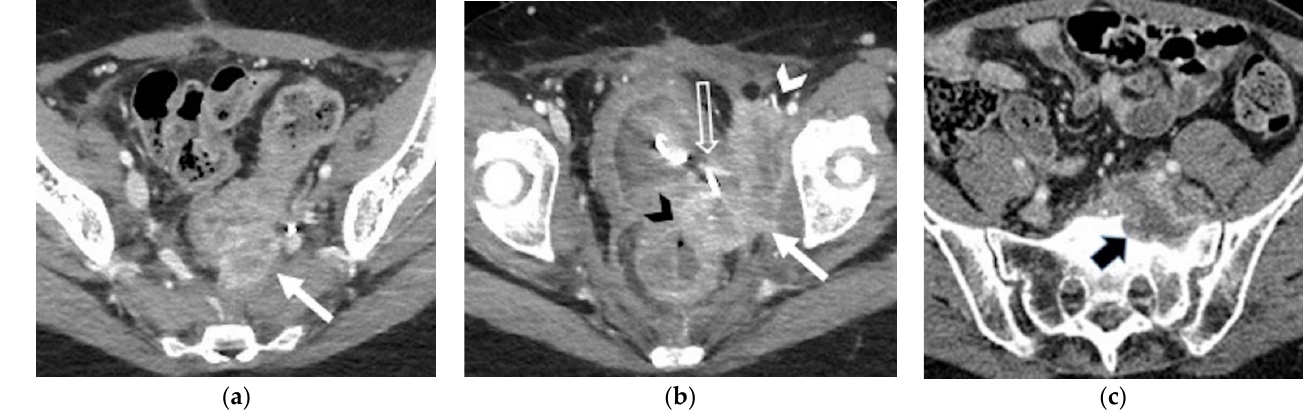
Figure 7. ( a , b ) A 36-year-old patient who underwent radical hysterectomy with bilateral salpingo– oophorectomy (BSO) and chemoradiation therapy for cervical cancer. Axial post-contrast CT images show pathological tissue infiltrating the left piriform muscle, the left internal obturator muscle (solid white arrow in ( a , b )) and the external iliac vein (white arrowhead in ( b )). Note the infiltration of the anterior rectal wall (black arrowhead in ( b )), the bladder and the left ureteral orifice (with the ureteral stent) (open arrow in ( b )). ( c ) A 58-year-old who underwent radical hysterectomy with BSO for cervical cancer. Axial post-contrast CT image shows pathological tissue infiltrating the left sacral promontory (black arrow).